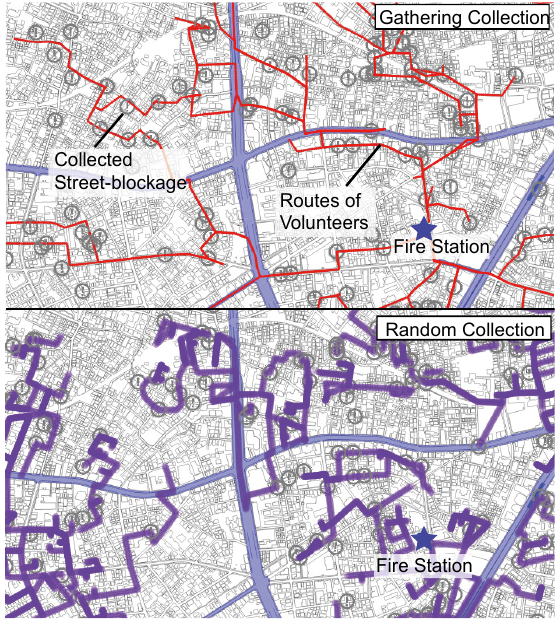
Figure 11. Example of collected information 4.3 The Difference between two